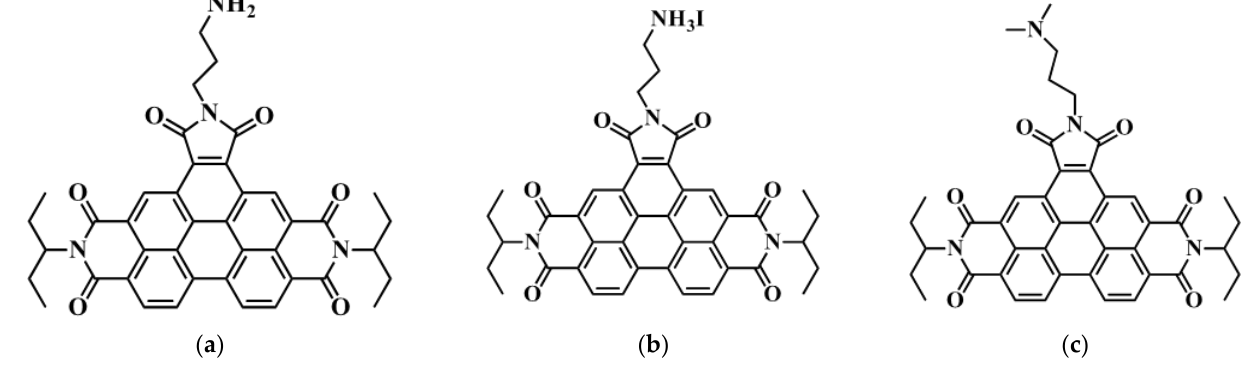
Figure 1. Chemical structures of the materials tested as interfacial layers. ( a ) BPTI-C 3 NH 2 ; ( b ) BPTI- C 3 NH 3 I; ( c ) BPTI-C 3 DMA.